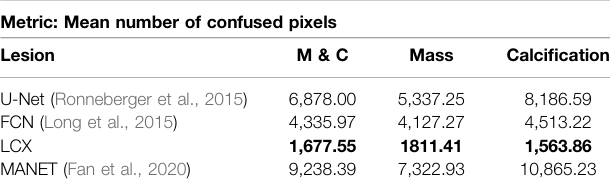
TABLE 4 | Confused Pixels. We fi nd out the average number of pixels in the predictions of different models such that their values lie between 0.3 and 0.7. We claim that these are confused pixels where the model is unsure of classifying them between healthy and pathological.